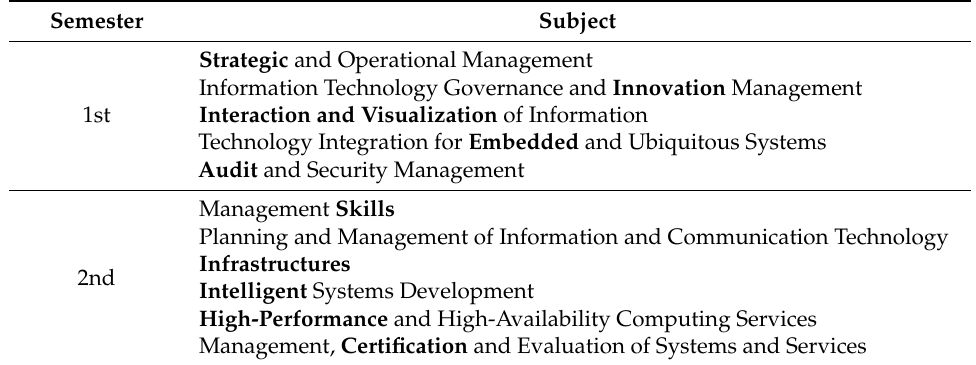
Table 1. Subjects of the master’s degree in Computer Engineering (MCE) 1